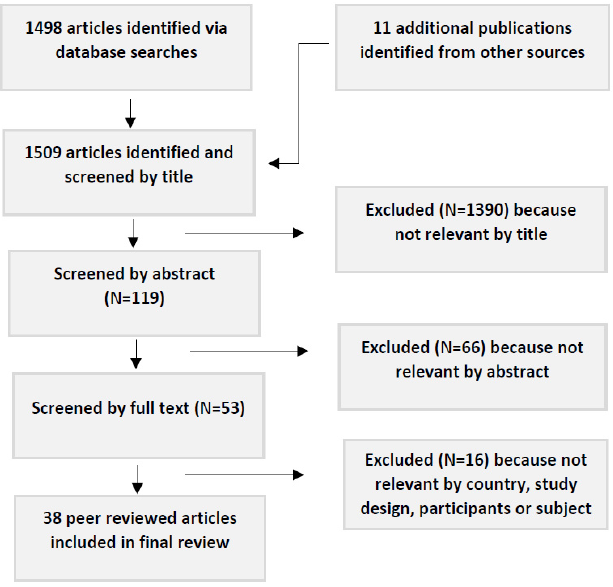
Figure 1. Flow chart showing procedure for article selection.